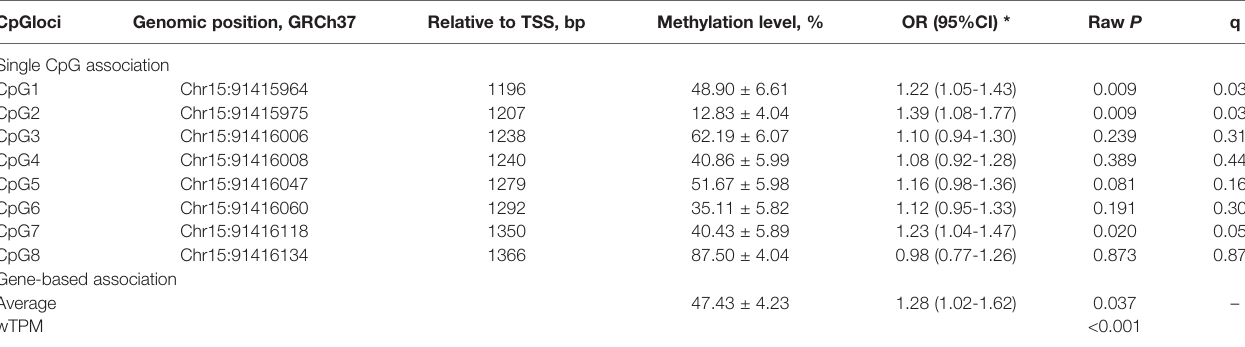
TABLE 2 | The prospective association between baseline FURIN promoter methylation and incident diabetes. CpGloci Genomic position,